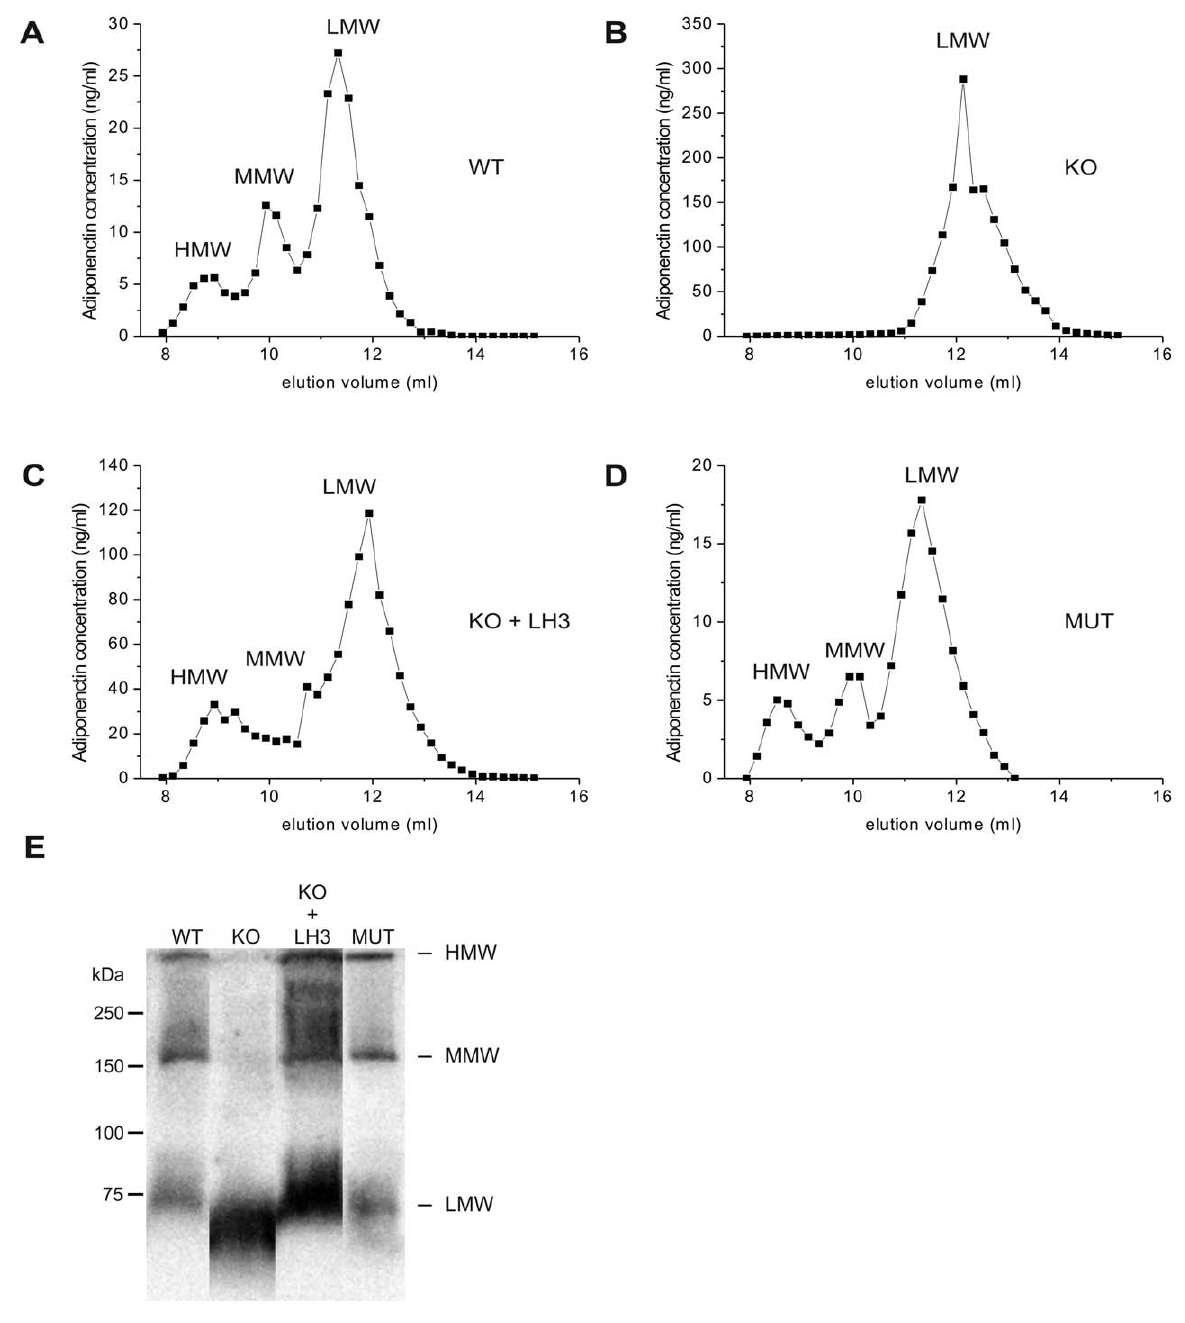
Figure 2. Oligomer distribution of recombinant adiponectin is altered in LH3 2 / 2 knockout MEF cells. The oligomeric forms of recombinant adiponectin were separated with gel filtration chromatography and quantified by ELISA. Comparison of typical gel filtration elution profiles of recombinant adiponectin produced in (A) wild type and (B) LH3 2 / 2 knockout MEFs indicates that HMW and MMW oligomers are not secreted from knockout cells. (C) Double transfection with adiponectin and LH3 constructs normalized the elution profile in LH3 2 / 2 knockout MEFs. (D) Recombinant adiponectin produced in LH mutant MEFs formed similar oligomers as the wild type. The adiponectin oligomers corresponding to the peaks seen with gel filtration chromatography were also detected on immunoblot (E) separated under non-reducing and non-heat-denaturing conditions. Equal volumes of concentrated cell culture media were used in all analysis. Representative elution profiles are shown. Abbreviations: WT=wild type; KO=LH3 2 / 2 knockout; LH3=lysyl hydroxylase isoform 3; MUT=LH